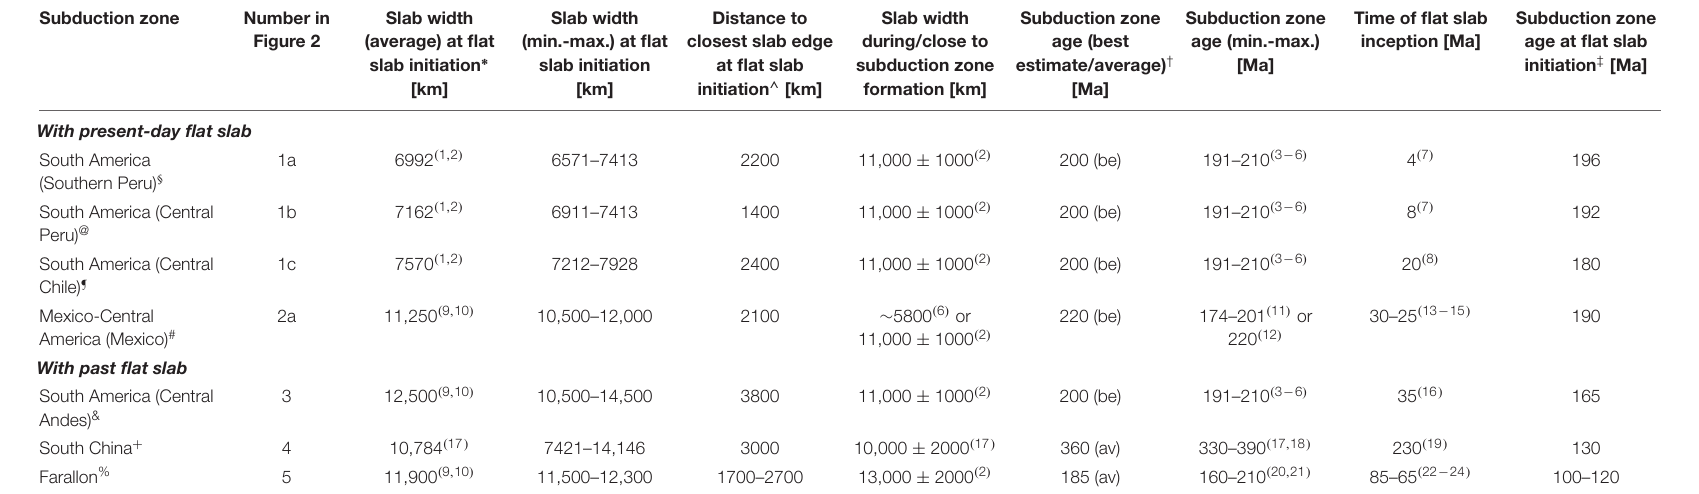
TABLE 1 | Subduction zones with a flat